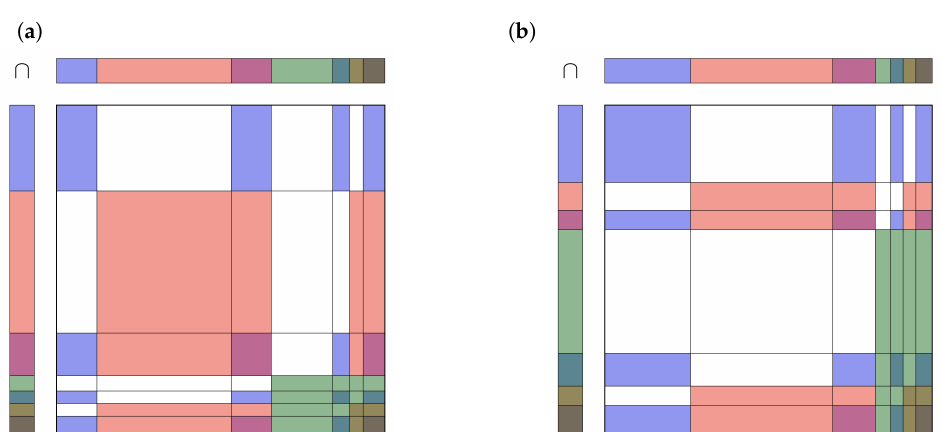
Figure 4. Intersection of basic belief masses of two pieces of evidence. The seven colors in the mosaic plot represent (in order) the seven sets { B } , { R } , { B , R } , { G } , { B , G } , { R , G } , { B , R , G } . The 49 rectangles within the two squares are colored according to the intersect. White represents the empty set ∅ . For a closed world, the white areas must be redistributed among all others. ( a ) rather consent pieces of evidence. ( b ) rather contradicting pieces of